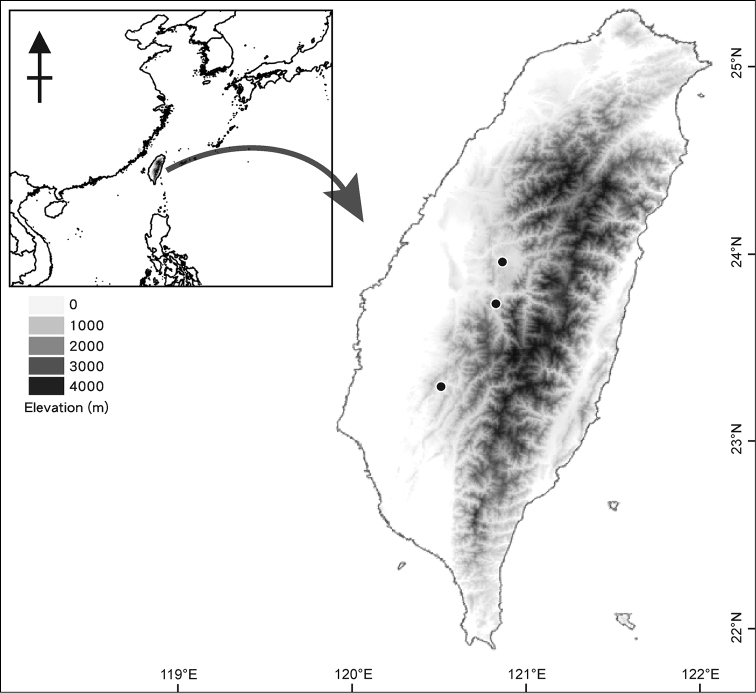
Distribution of Bolbitis
lianhuachihensis (black circles) in Taiwan.